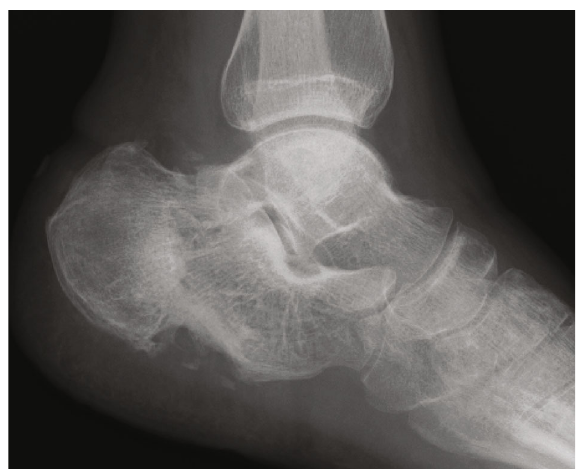
Figure 7: Three months after the injury, successful bone healing without any symptoms was